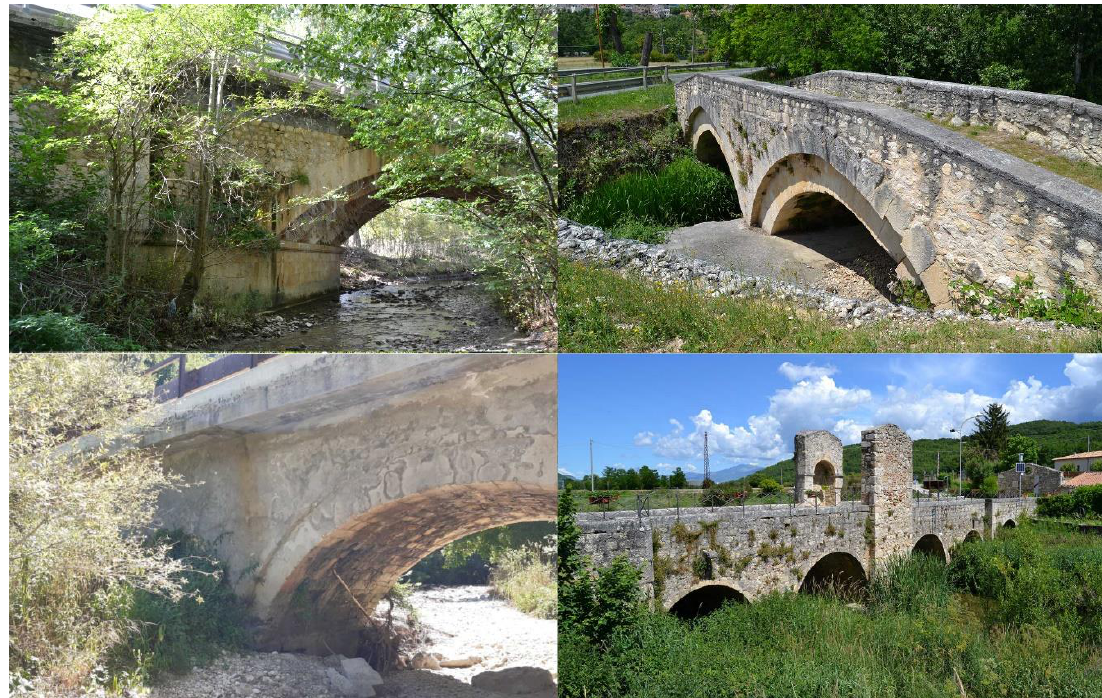
Figure 6. Photographic documentation of some arch masonry bridges along the Aterno River.